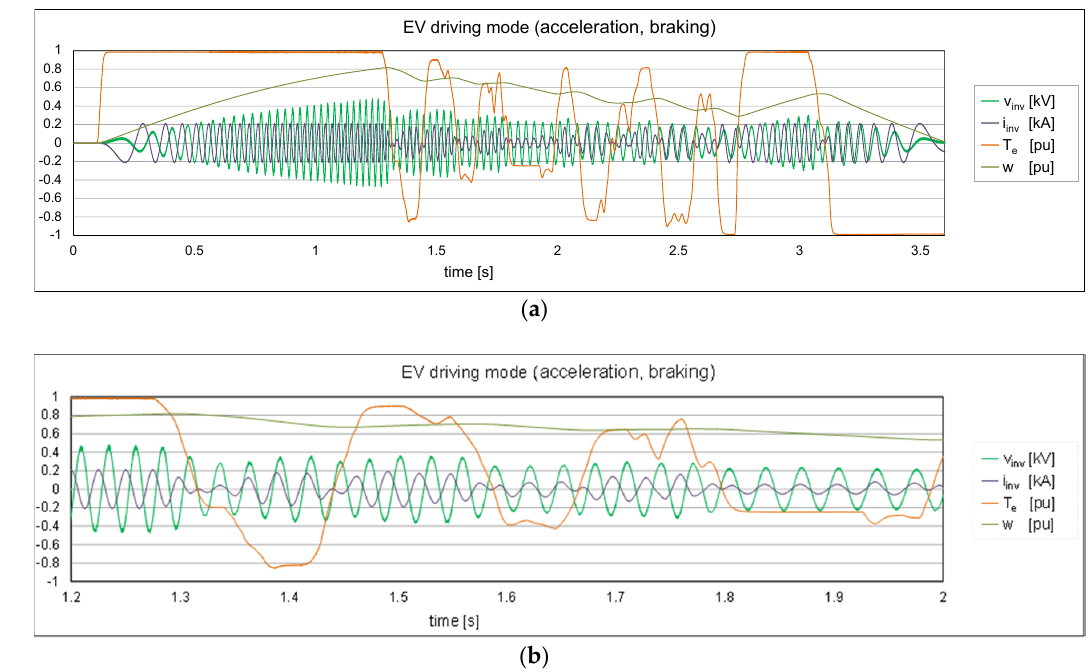
Figure 4. ( a ) EV driving state (accelerating and braking); ( b ) The zoom of the upper diagram, period (1.2–2)s.